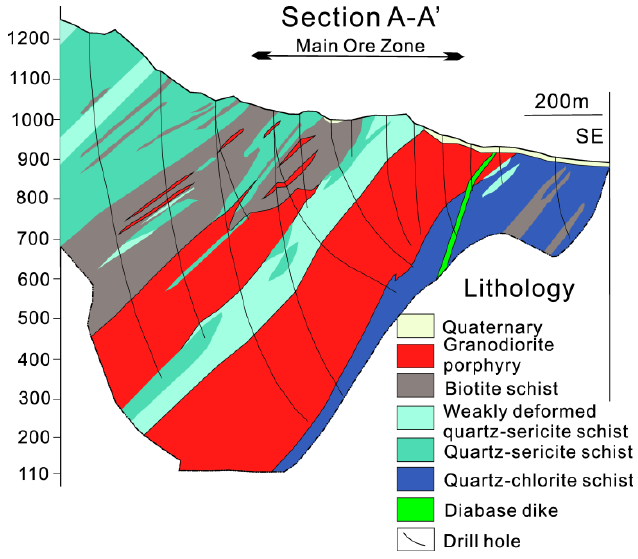
Figure 3. Geological section of the main ore veins (modified after 214 Geological Group in Zhong- tiaoshan in Shanxi Province, unpub. report, 1956; Meng et al., 2020